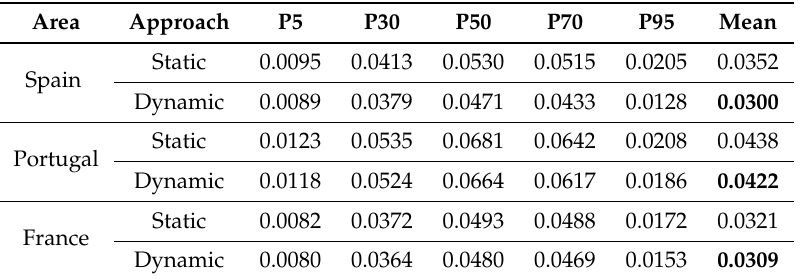
Table 9. Pinball loss function for daily